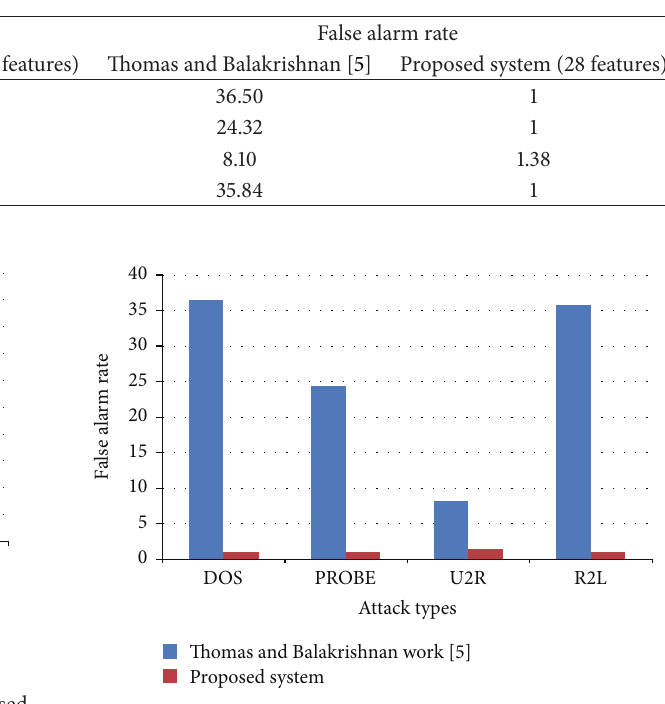
Table 7: Comparison of detection rate and false alarm rate for Thomas and Balakrishnan [5] work and proposed system for different attack.